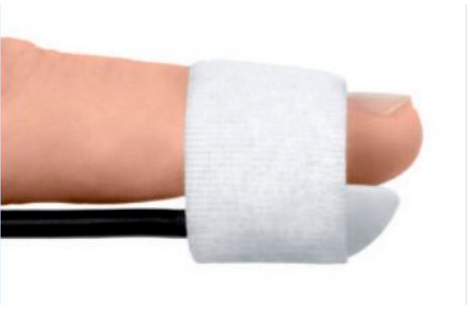
Figure 1. Example of dual PES/PCS sensor affixed to the index finger.